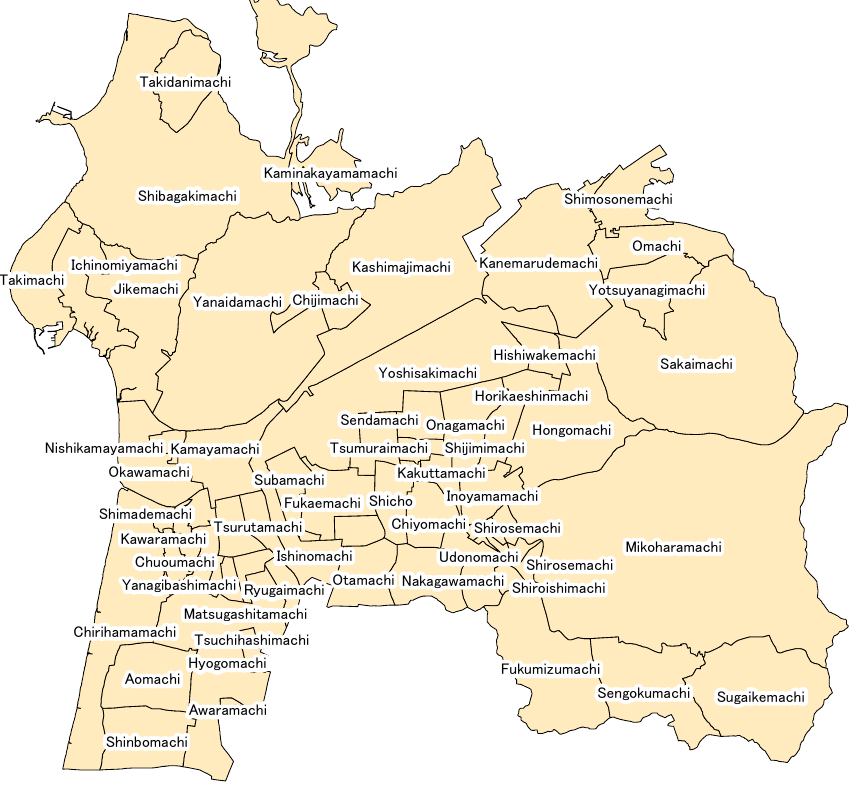
Figure 1. Hakui City in Ishikawa Prefecture and neighborhood segments.